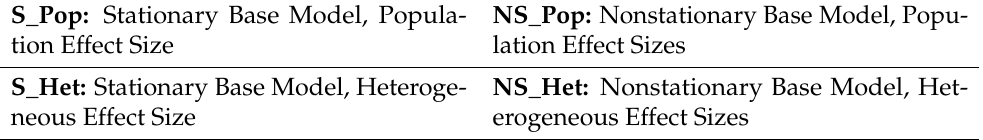
Table 1. Four Environment Variants. We consider two environment base models (stationary and nonstationary) and two effect sizes (population effect size, heterogeneous effect